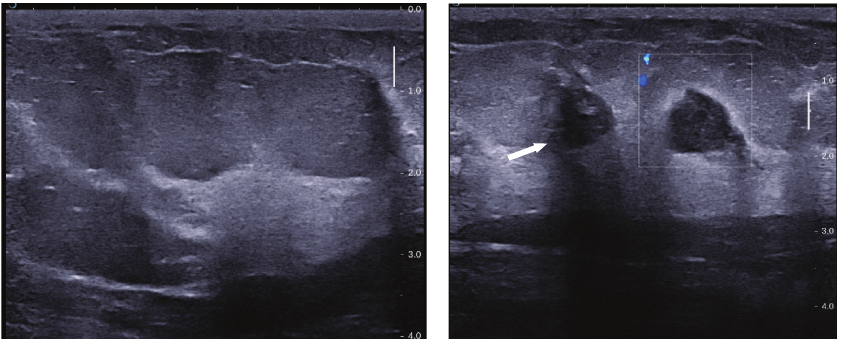
Figure 7: Edematous changes in the breast seen at presentation. Subsequent image shows progression of radiological features as reflected by interval development of cystic change and abscess formation (arrow).